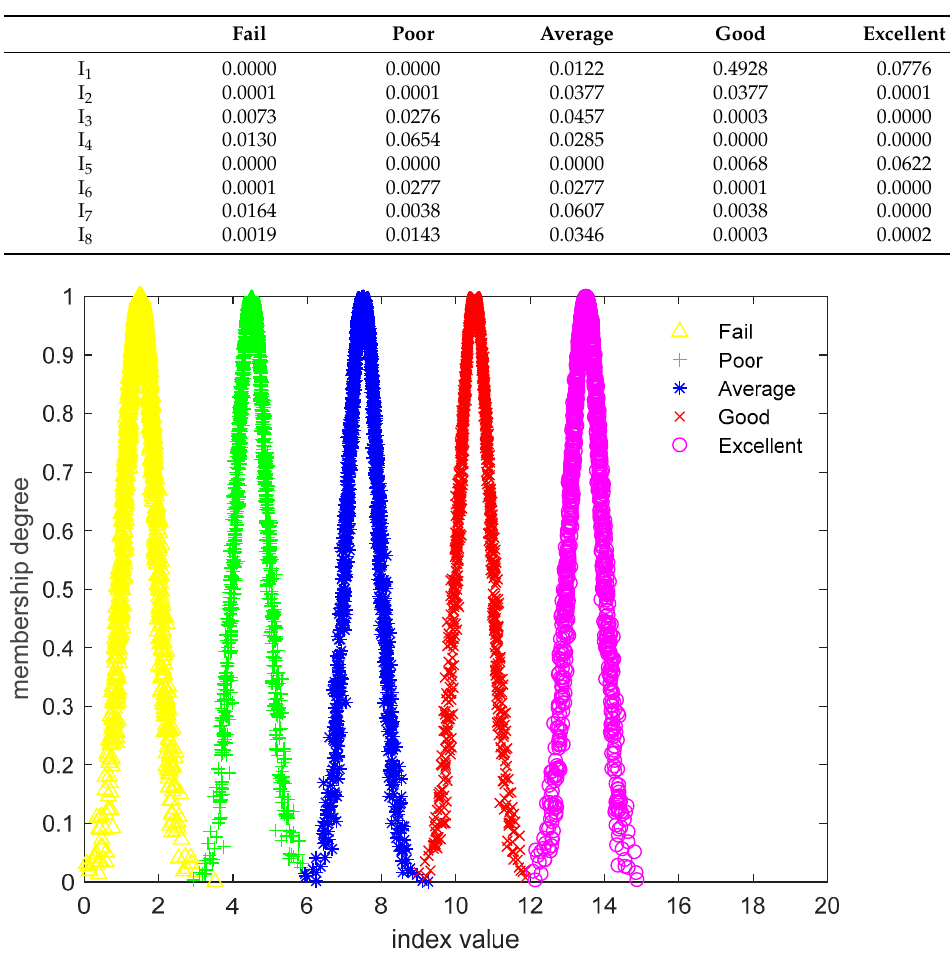
Table 5. Membership degree of electric bus A.